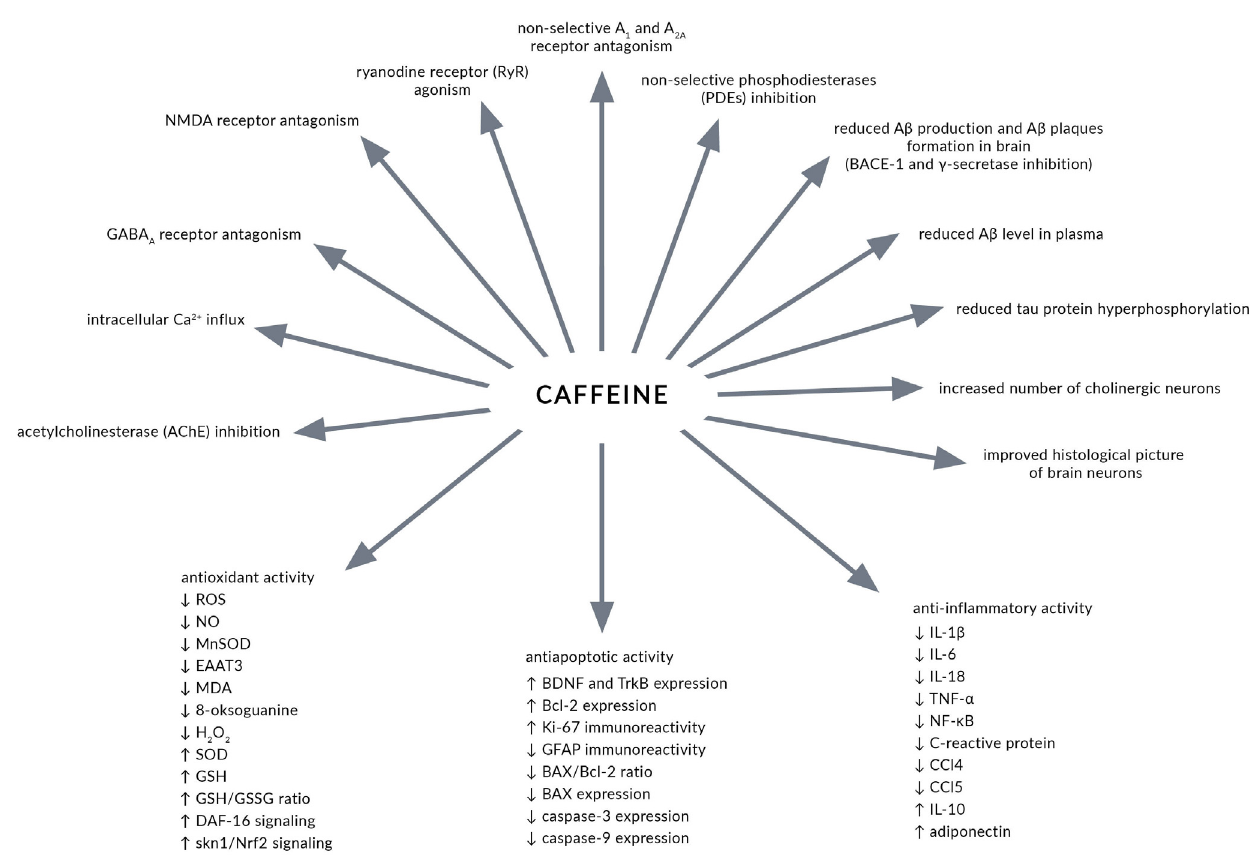
Figure 1. Caffeine effects reported in studies performed in experimental models of Alzheimer’s disease (AD). A β —amyloid β . AChE—acetylcholinesterase. BACE-1— β -site amyloid-precursor-protein-cleaving enzyme-1. BAX—B-cell lymphoma 2- associated X protein. Bcl-2—B-cell lymphoma protein-2. BDNF—brain-derived neurotrophic factor. CCl—chemokine ligand factor. DAF-16—abnormal dauer formation 16. EAAT3—excitatory amino acid transporter 3. GABA A — γ -aminobutyric acid type A receptor. GFAP—glial fibrillary acidic protein. GSH—reduced glutathione. GSH/GSSG ratio—reduced/oxidized glutathione ratio. IL—interleukin. MDA—malondialdehyde. MnSOD—manganese superoxide dismutase. NF- κ B—nuclear factor- κ B. NMDA—N-methyl-D-aspartate. Nrf2—nuclear factor erythroid 2-related factor 2. PDE—phosphodiesterase. ROS—reactive oxygen species. RyR—ryanodine receptor. skn-1—skinhead 1. SOD—superoxide dismutase. TNF- α —tumor necrosis factor α . TrkB—tropomyosin-related kinase receptor